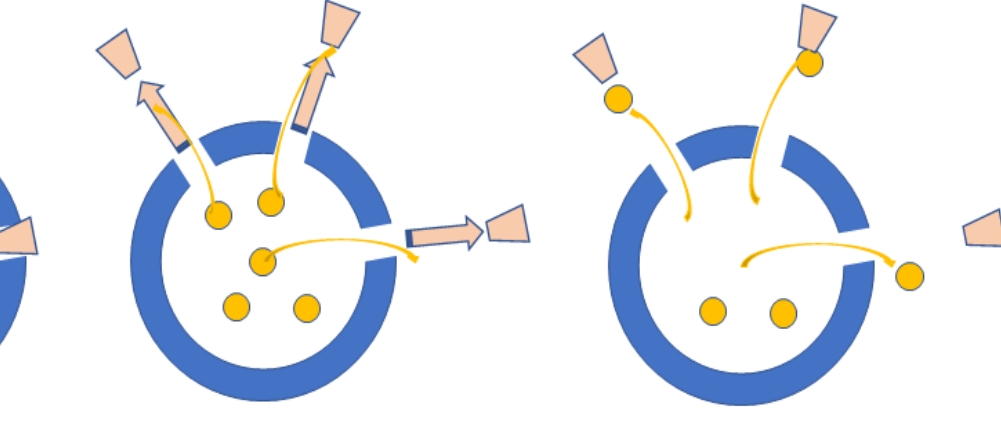
Figure 3. Nanovalves sensitive to pH incorporated onto the surface of silica nanocontainers.